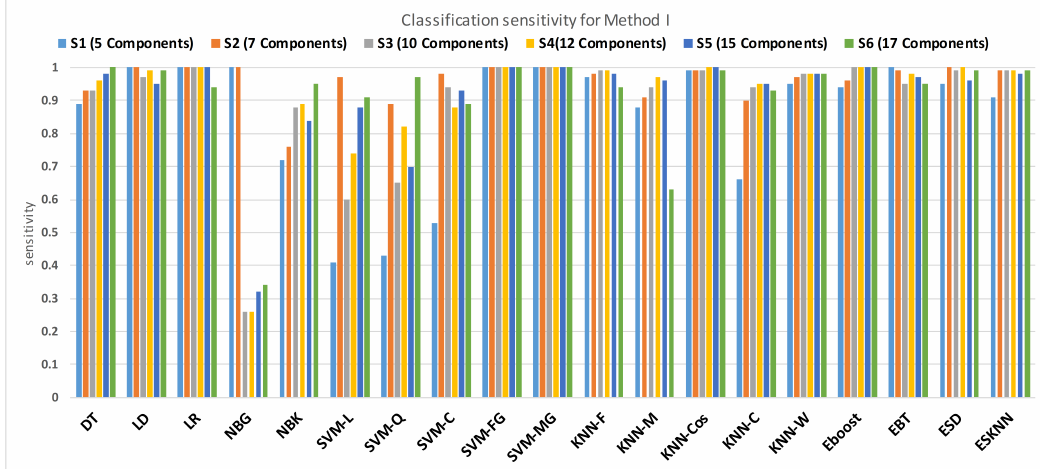
Figure 11. Performance of accuracy for different feature sets in various classifiers for PuPG signal through method I.